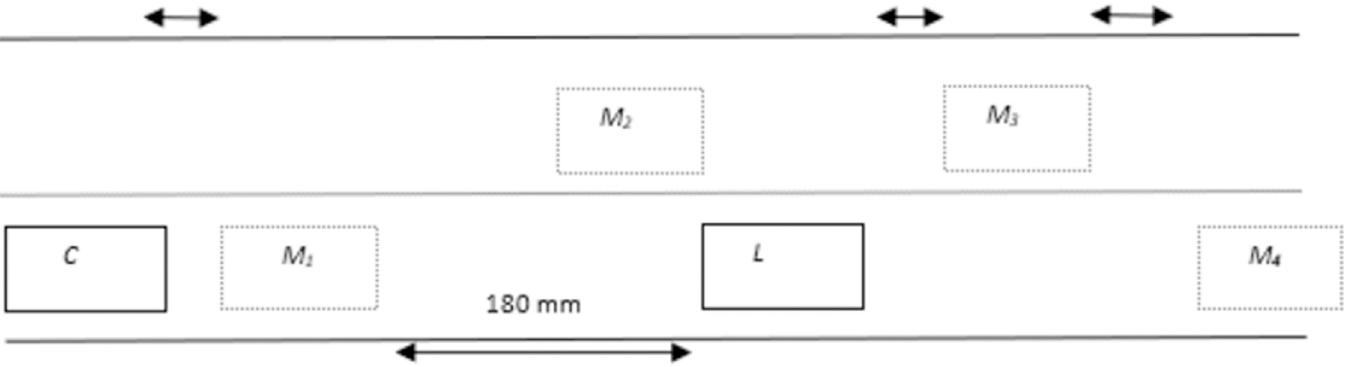
Fig 16. Experiment 1- simulated path (a) Original RG method (b) Modified RG method.